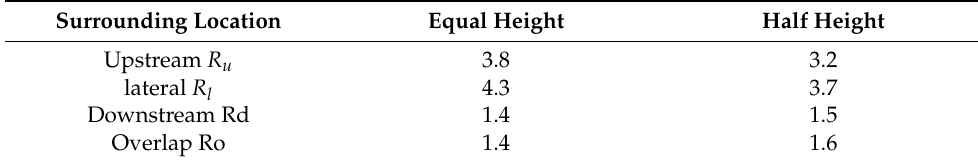
Table 8. Th regression results of the influence coefficient of the blockage